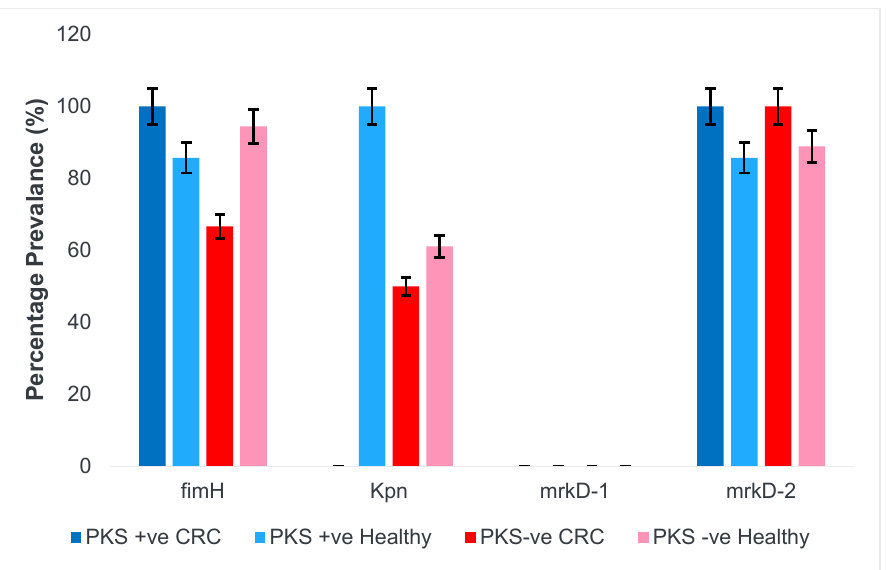
Figure 3. Prevalence of fimbriae and adhesins among K. pneumoniae isolates. Adhesins ( mrkD1, Figure 3: Prevalence of fimbriae and adhesins among K. pneumoniae isolates. mrkD2, fimH, kpn Adhesins ( mrkD1, mrkD2, fimH, kpn ).